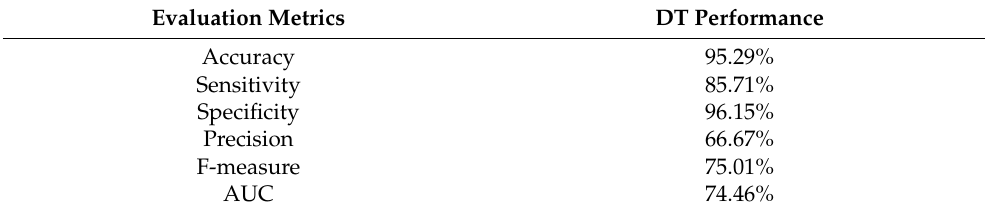
Table 2. Results of DT without applying RFE and SMOTETomek techniques.